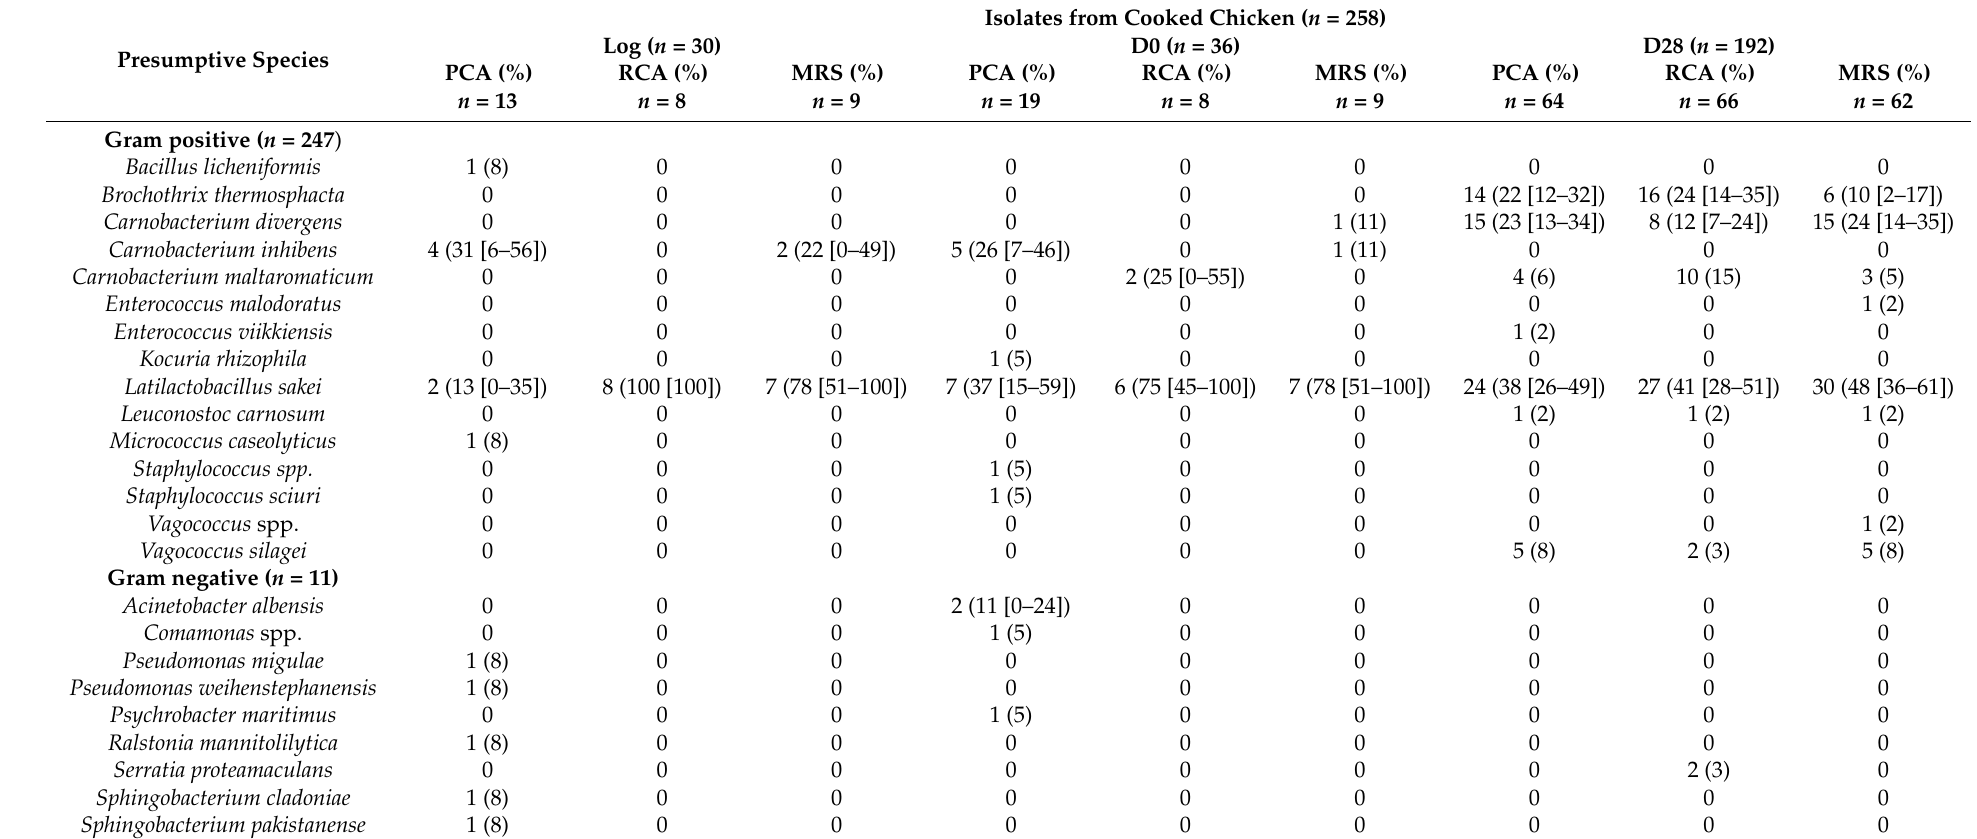
Table 3. Genus and presumptive species identity of isolates from PCA, RCA and MRS agar media for the cooked chicken samples. Percentages of isolates were calculated on the total of identified isolates per medium. Confidence intervals for percentages of number of identified isolates are calculated for the three most abundant (if three were present) identifications per sampling moment from PCA, RCA and MRS agar media and are presented between square